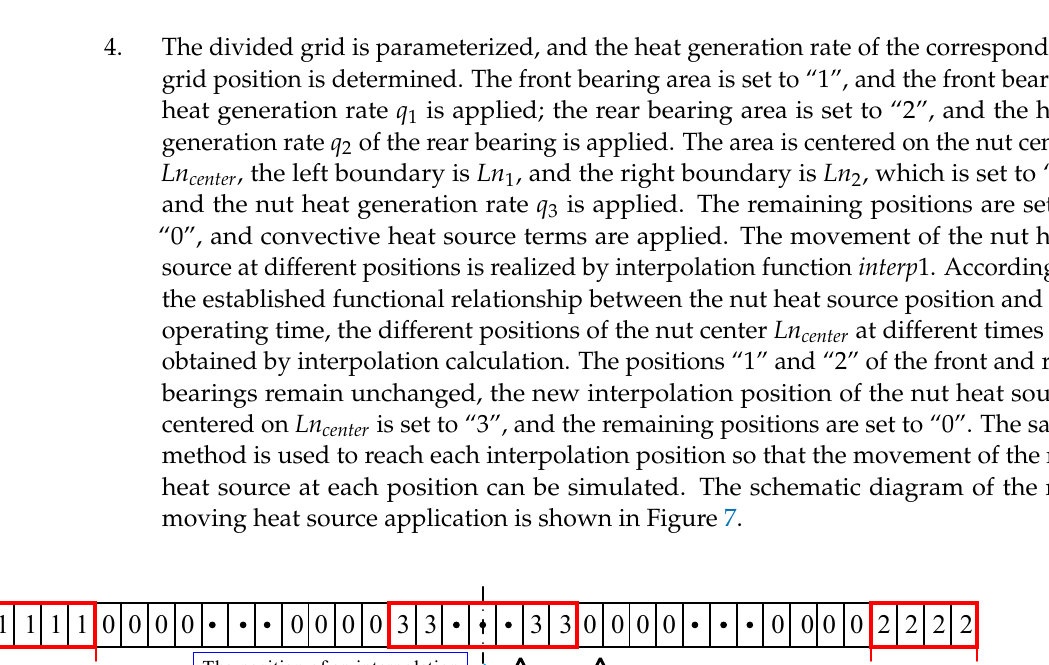
Figure 6. Function diagram: ( a ) The function diagram between the nut heat source position and operating time; ( b ) enlarged diagram of the function between the nut heat source position and the operating time.